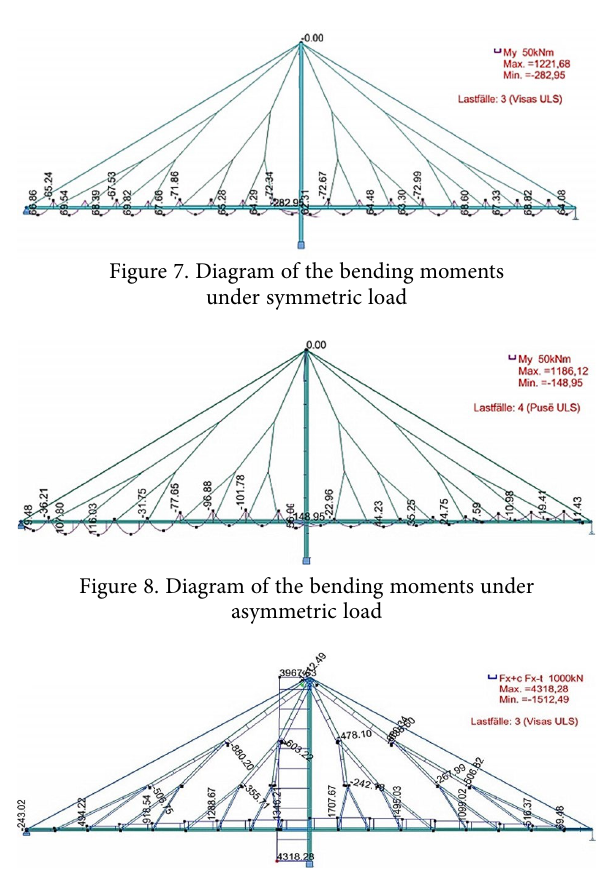
Figure 9. Diagram of the axial forces under symmetric